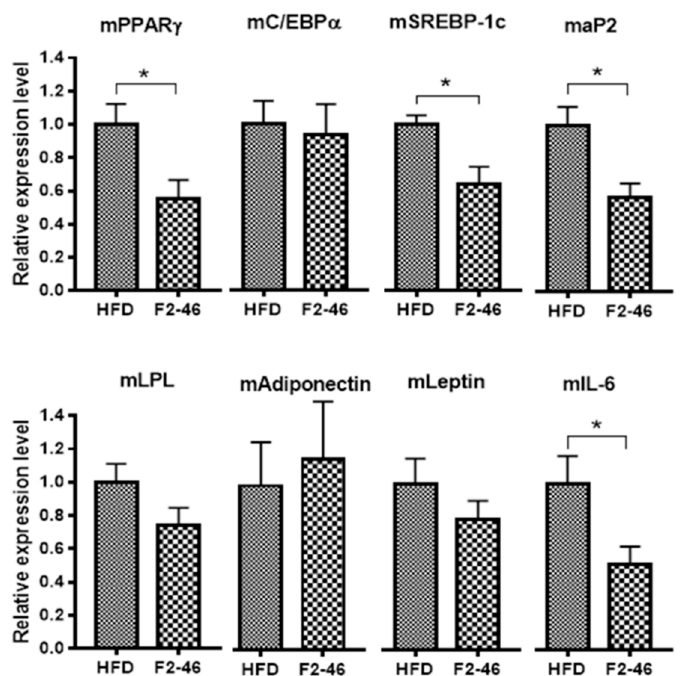
Figure 5. Effect of F2 on the mRNA expression levels of PPAR γ , C/EBP α , SREBP-1c, aP2, LPL, adiponectin, leptin, and IL-6 in white adipose tissue. β -actin was used as a reference gene. Values are expressed as the mean ± SEM (n = 4). A one-way ANOVA was applied to calculate statistical significance. * p < 0.05 vs. HFD control. HFD = high-fat diet control; F2-46 = F2 (46 mg/kg).